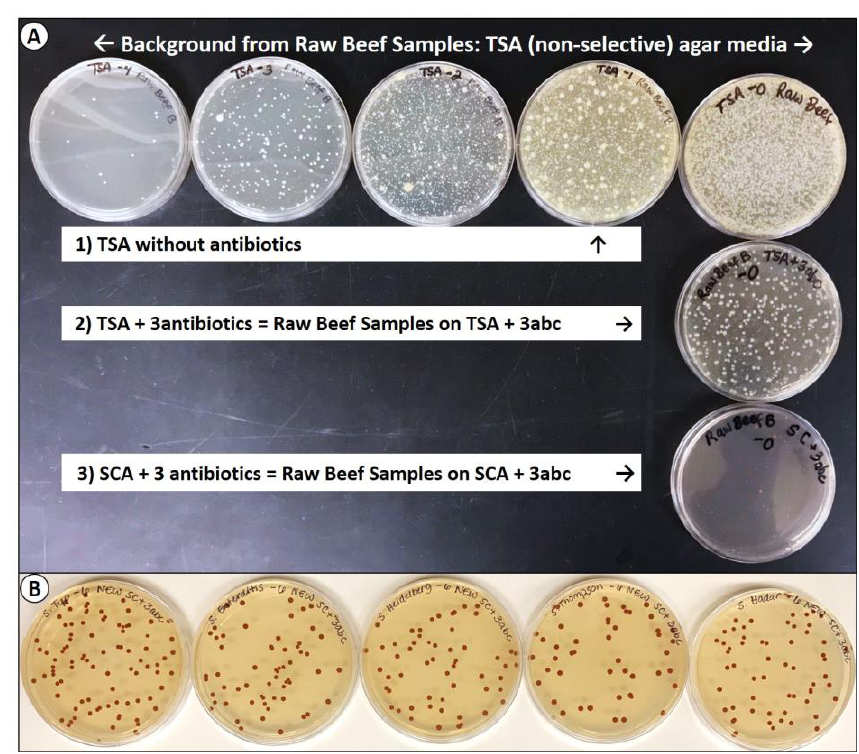
Figure 4. Comparison of TSA (without antibiotics) vs. TSA and selinite cystine agar (SCA) (with antibiotics). ( A ) Plating of samples taken from fresh raw meat onto TSA without antibiotics (top row), vs. TSA containing antibiotics (2nd row), vs. SCA containing antibiotics (3rd row). The “3abc” represents the ‘three antibiotics’ described previously: Spectinomycin (5 ug / mL), novobiocin (50 ug / mL), and clindamycin (5 ug / mL). ( B ) Individual Salmonella serovars surface plated (10 − 6 dilution) on SCA containing three antibiotics.